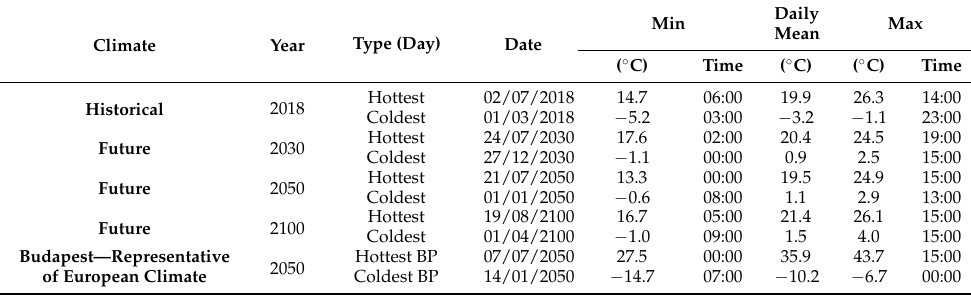
Table 5. Overview of hottest and coldest daily external temperature